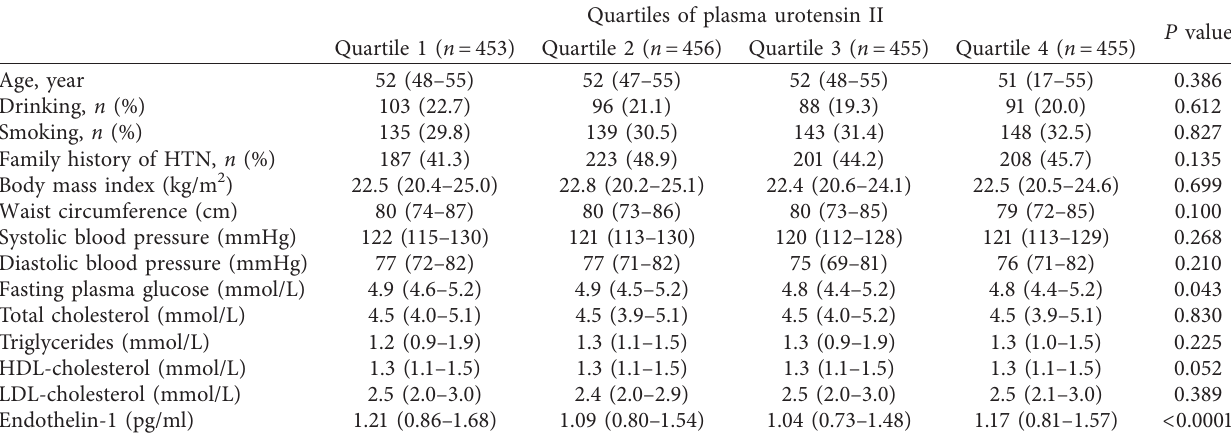
Table 1: General characteristics of the 1819 participants by quartiles of levels of urotensin II at baseline.